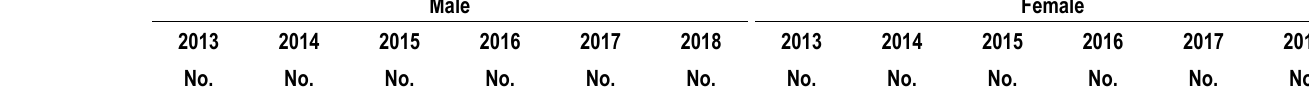
Table 11a. Stage 3 (AIDS) attributed to injection drug use, by selected characteristics, 2013–2018—United States (cont)